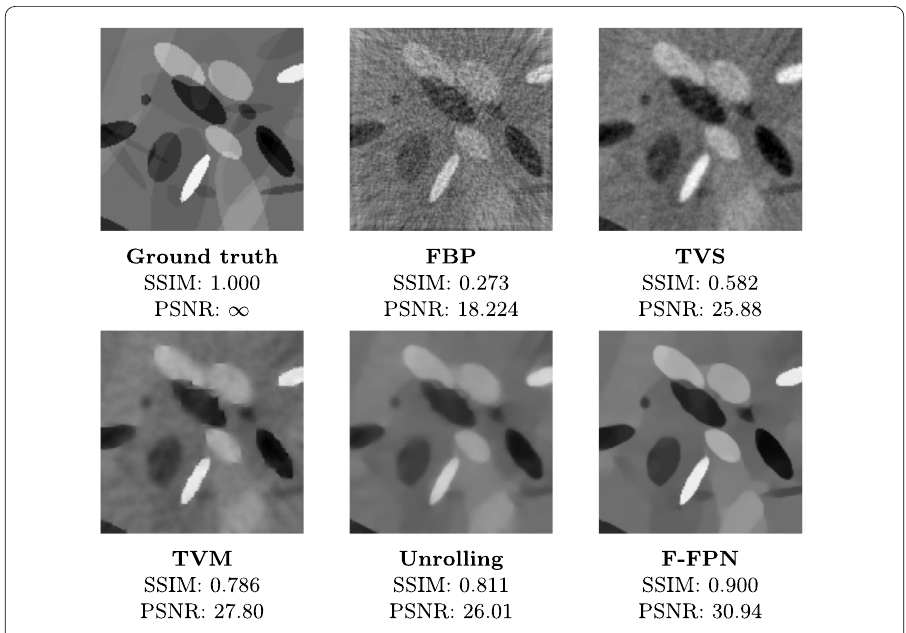
Figure 2 Ellipse reconstruction with test data for each method: filtered back projection (FBP), TV superiorization (TVS), TV minimization (TVM), unrolled network, and the proposed feasibility-based fixed point network